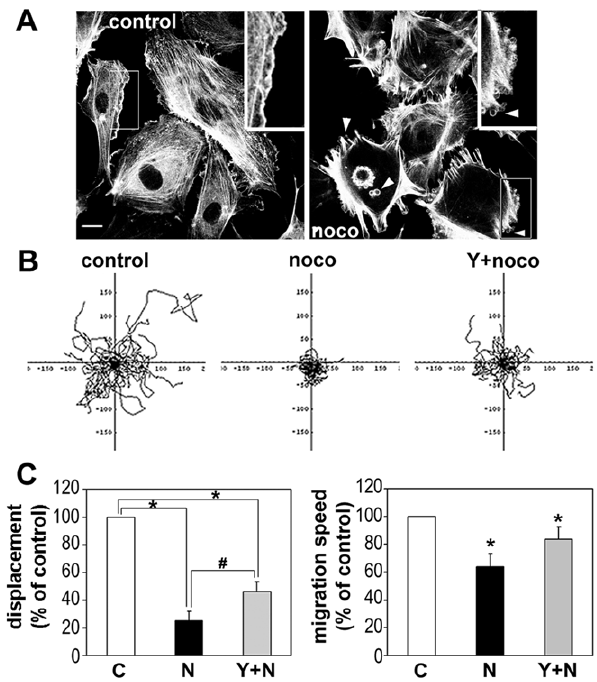
Figure 7. Y-27632 rescues the effect of nocodazole on endothelial cell migration. (A) Nocodazole induces membrane blebbing in HUVECs. Nocodazole (noco, 0.2 m M) was added to HUVECs for 30 min, then cells were fixed and stained with phalloidin to